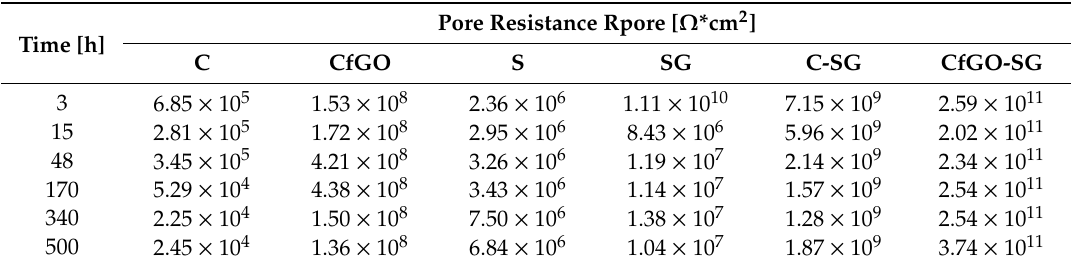
Table 3. Pore resistance values of the six samples series.